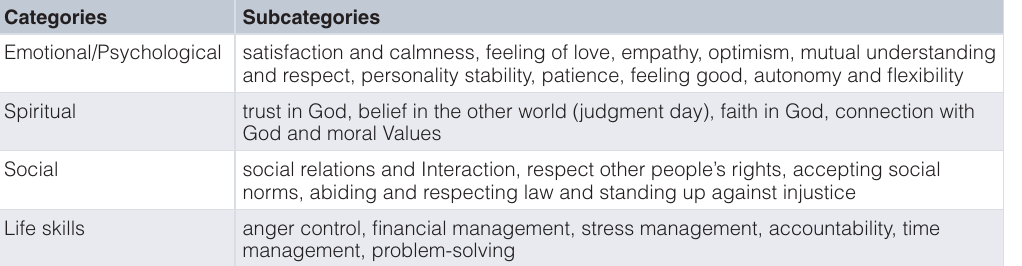
Table 2. Subthemes associated with domains of